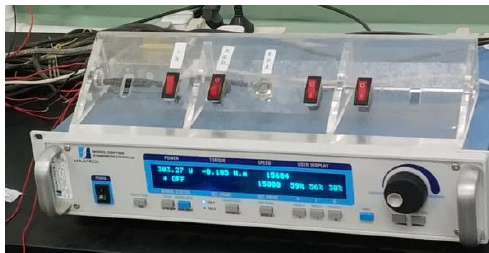
Figure 21. Mechanical power output Figure 20. The assembled micro Wankel engine.